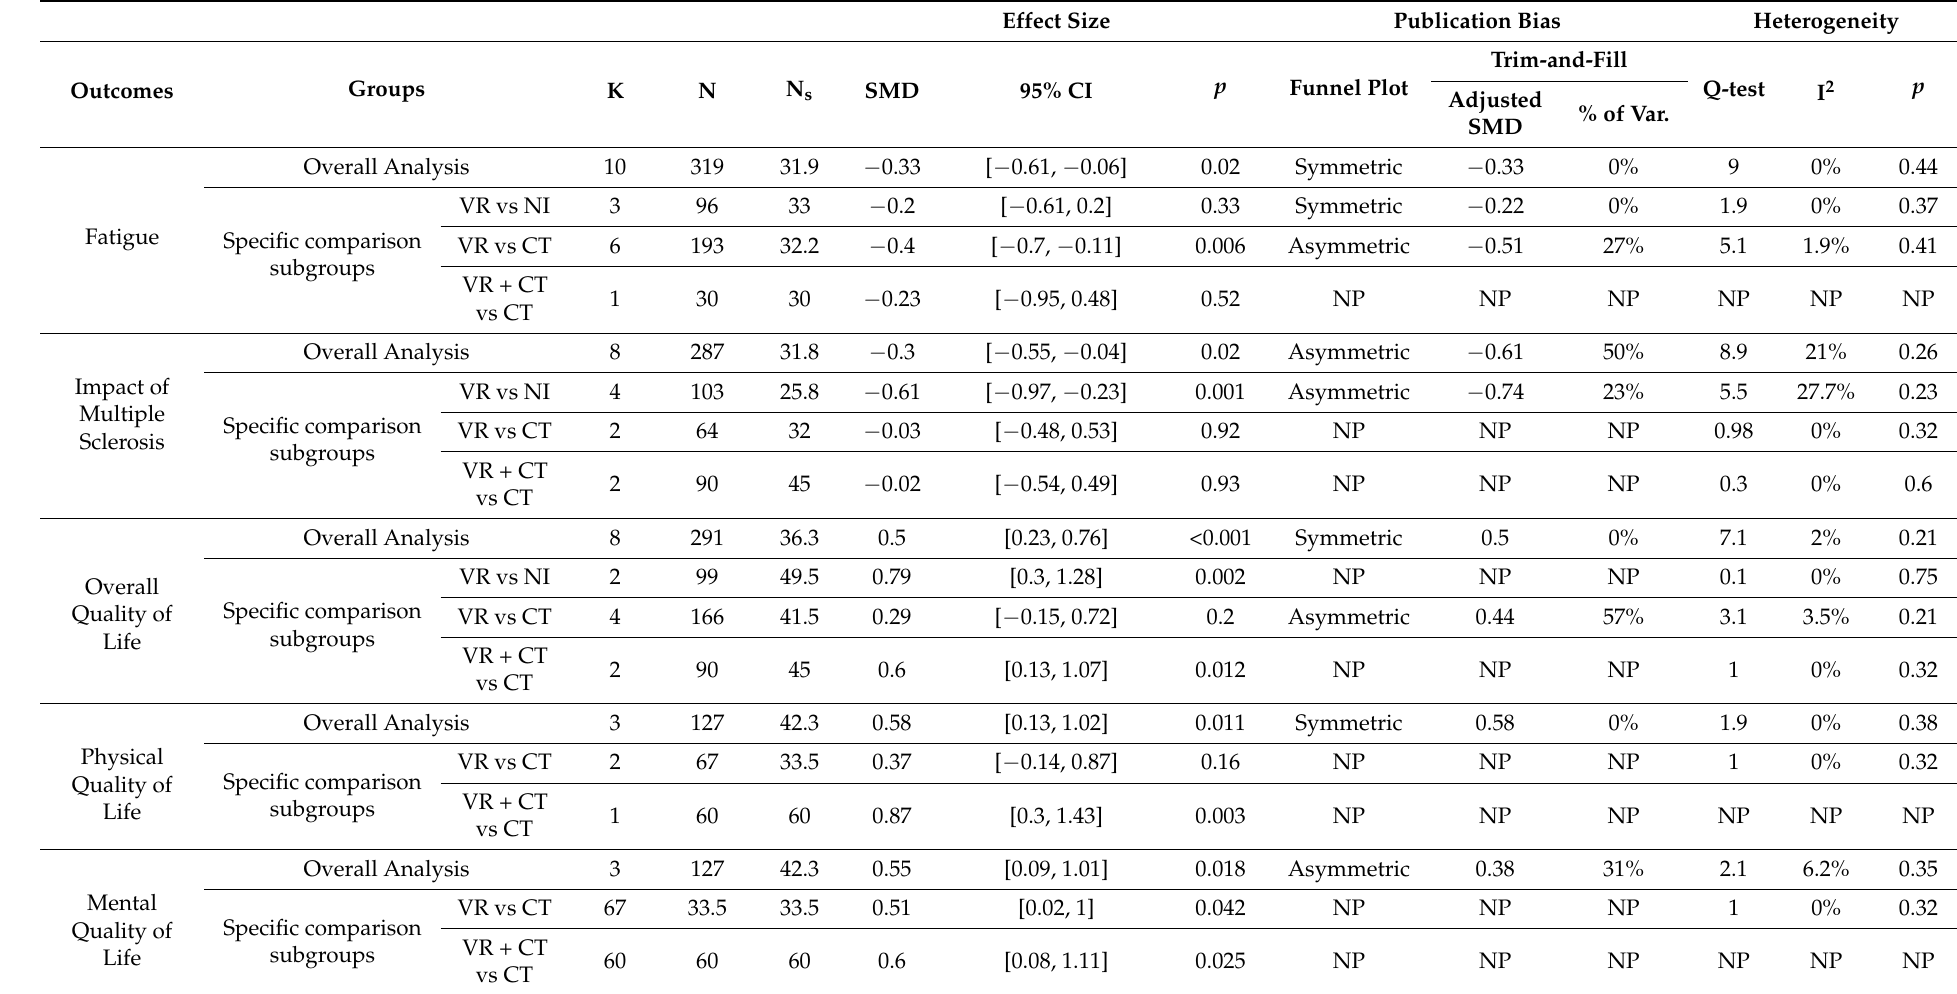
Table 4. Main Findings in